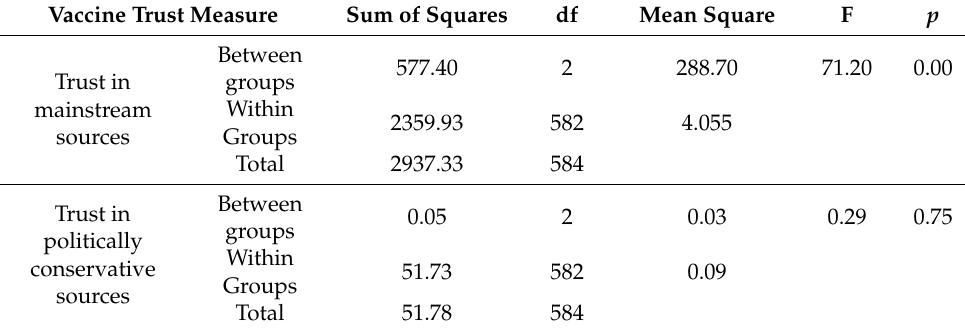
Table 4. Results from a fixed-effects ANOVA on trust in mainstream and politically conservative sources, using likelihood of getting the coronavirus vaccine as the criterion, conducted among study participants in the US, 2020 ( N = 585).